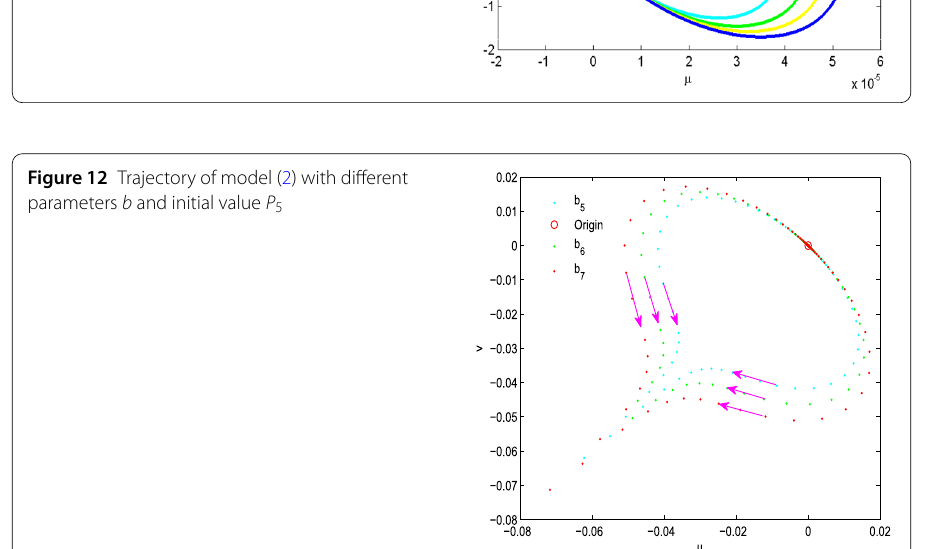
Figure 12 Trajectory of model (2) with different parameters b and initial value P